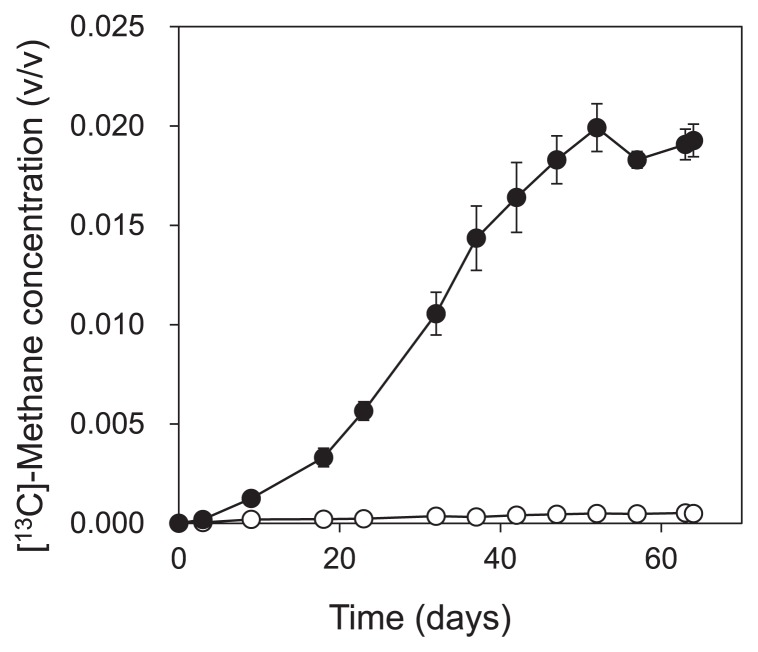
13C-methane concentration during incubation of the ●: labeled treatment, and ○: unlabeled, and ●: labeled treatment. Error bars show the standard error for three replicates in each treatment.